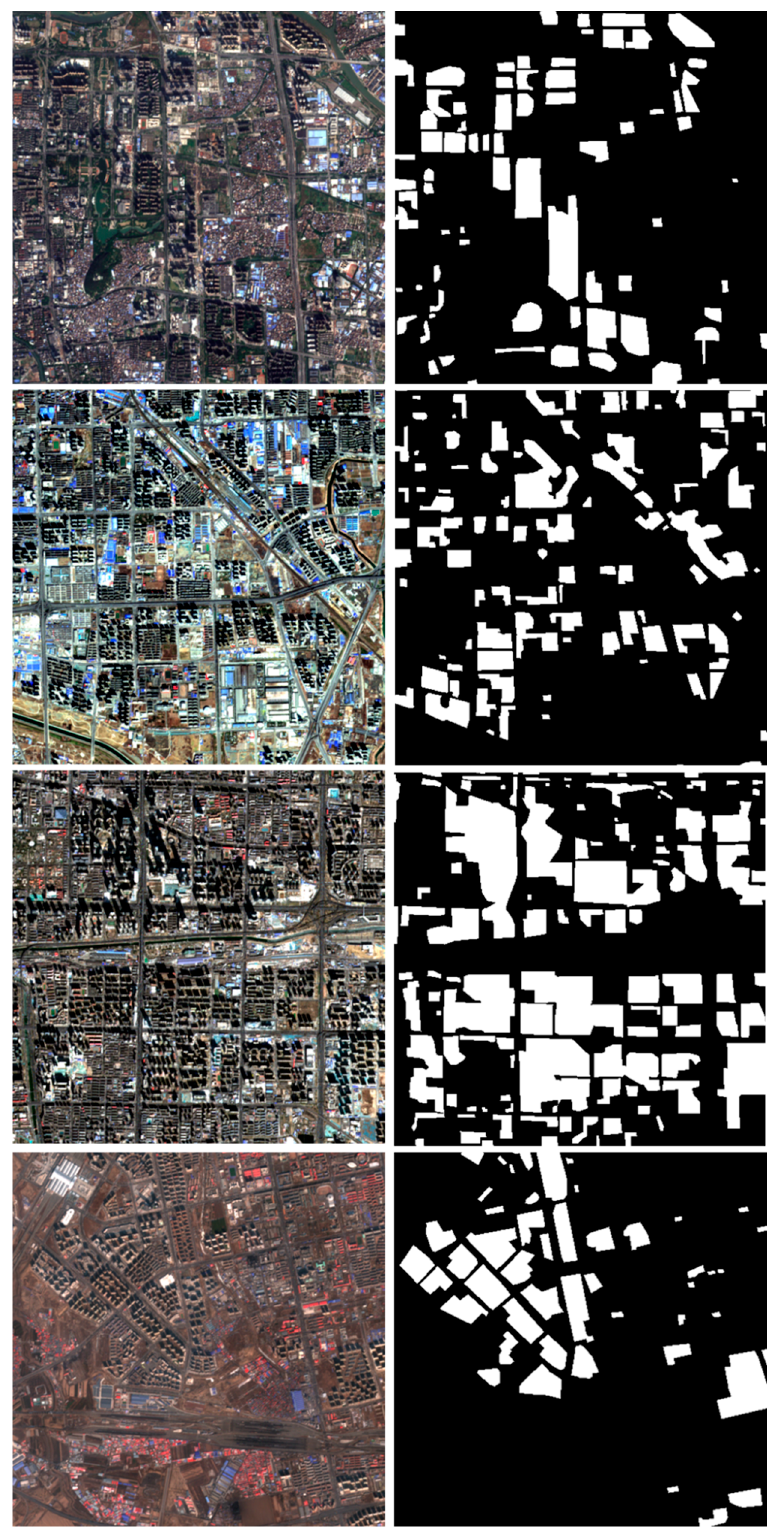
Figure 2. True color images in Spring and the corresponding HRBs masks in test1 in Guangzhou, Zhengzhou, Beijing, and Harbin from top to bottom, respectively.